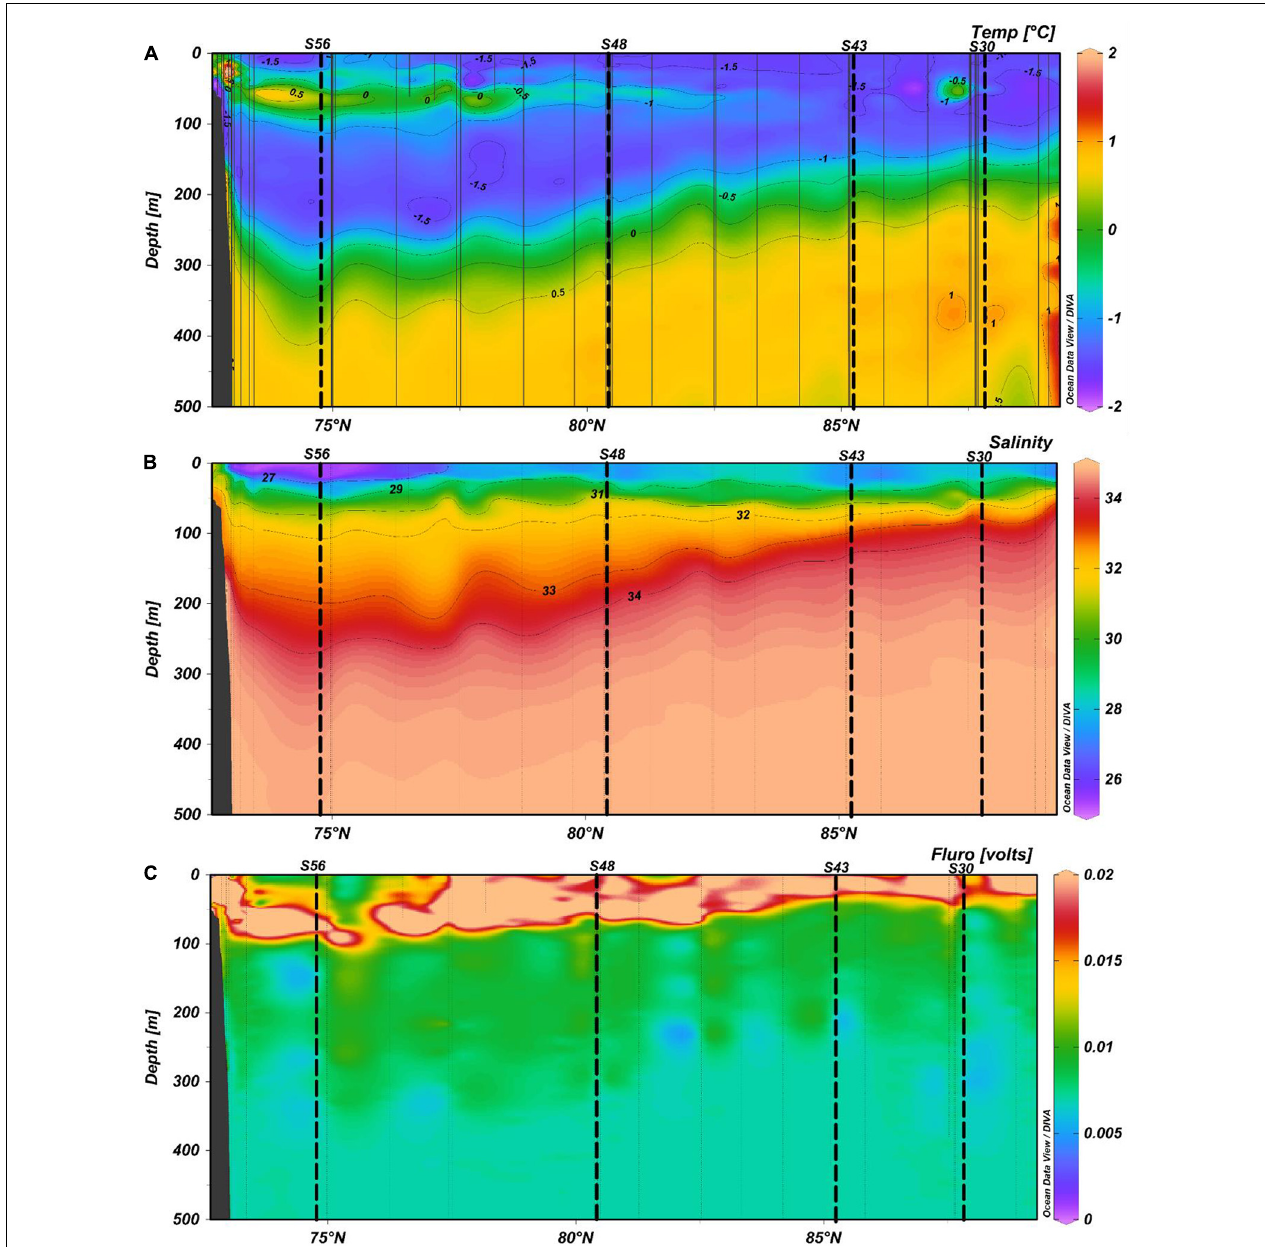
FIGURE 2 | Northbound section plots of (A) water temperature ( ◦ C), (B) salinity (sal) and (C) fluorescence (volts -relative units) in the upper 500 m water column. The vertical dashed lines represent the sampling stations along the transect. The transect images were created using Ocean Data View 5.2.0.